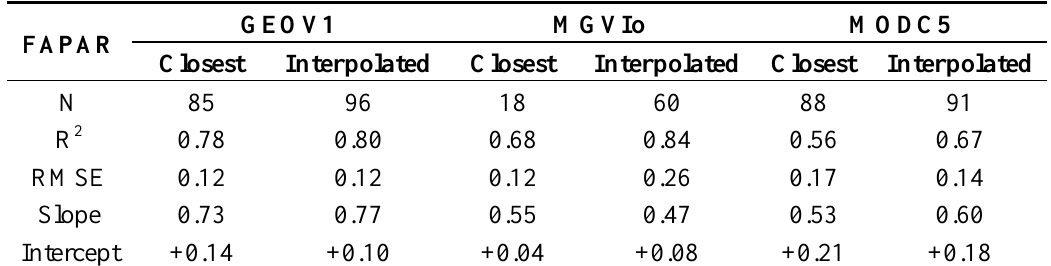
Table 4. Performances of GEOV1, MGVIo and MODC5 FAPAR products against ground validation measurements for the DIRECT sites. N is the number of observations (one site, one date), R 2 , the coefficient of determination, RMSE, the Root Mean Square Error and Slope and Intercept are computed from linear